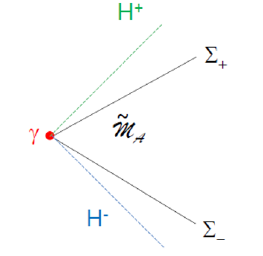
Figure 3 . We take our black hole exterior M A to include the bifurcation surface γ (red dot), but not the past horizon H − (dashed blue) or the future horizon H + (dashed green). As a result, the quotient by e ξT may also be described by introducing two slices Σ ± (each at a constant Killing time ± T/ 2 ), focussing on the region e M A between them, and identifying Σ + with Σ i . This is a special case of the cut-and-paste construction of section 2 using only a single spacetime M 1 = M A . Note that any geodesic that remains in the region e M A and approaches the bifurcation surface must do so in a spacelike manner. As a result, the quotient M A,T contains no null congruences that approach the image of the bifurcation surface. This means that M A,T has N = 0 in the notation of section 2. Recall also that the image of γ in M A,T will be called γ e